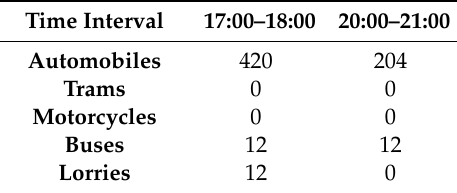
Table 4. Tra ffi c flow in the control area at di ff erent time